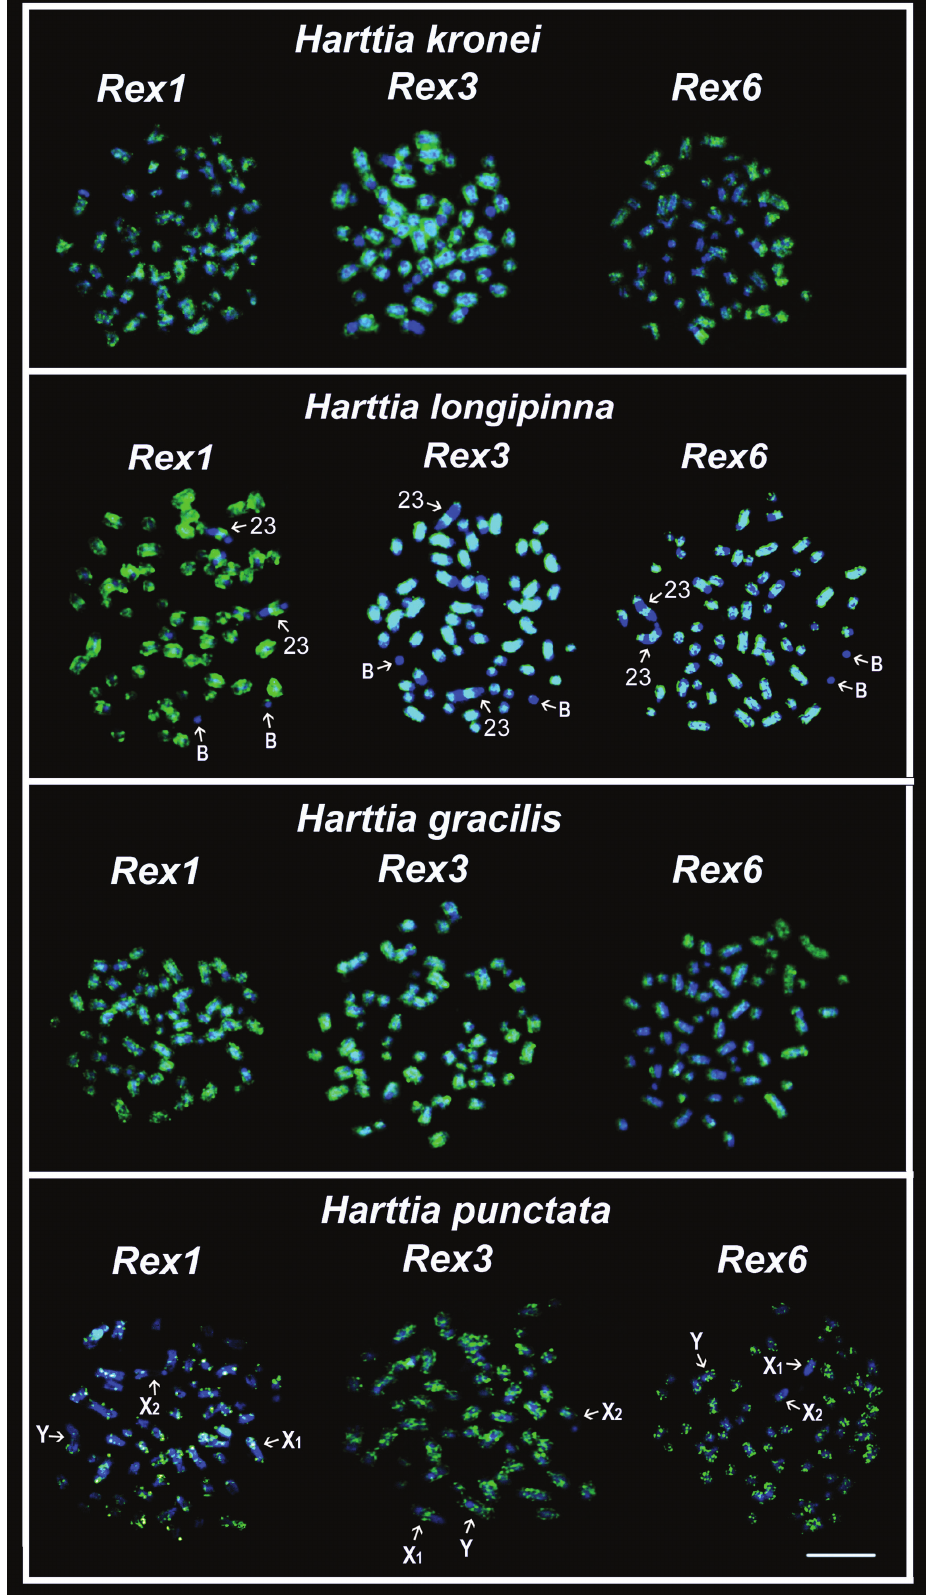
Fig. 1. Metaphases of the Harttia species submitted to FISH with probes of the Rex elements. The numbers indicate chromosomal pairs in highlighted. Bar = 10